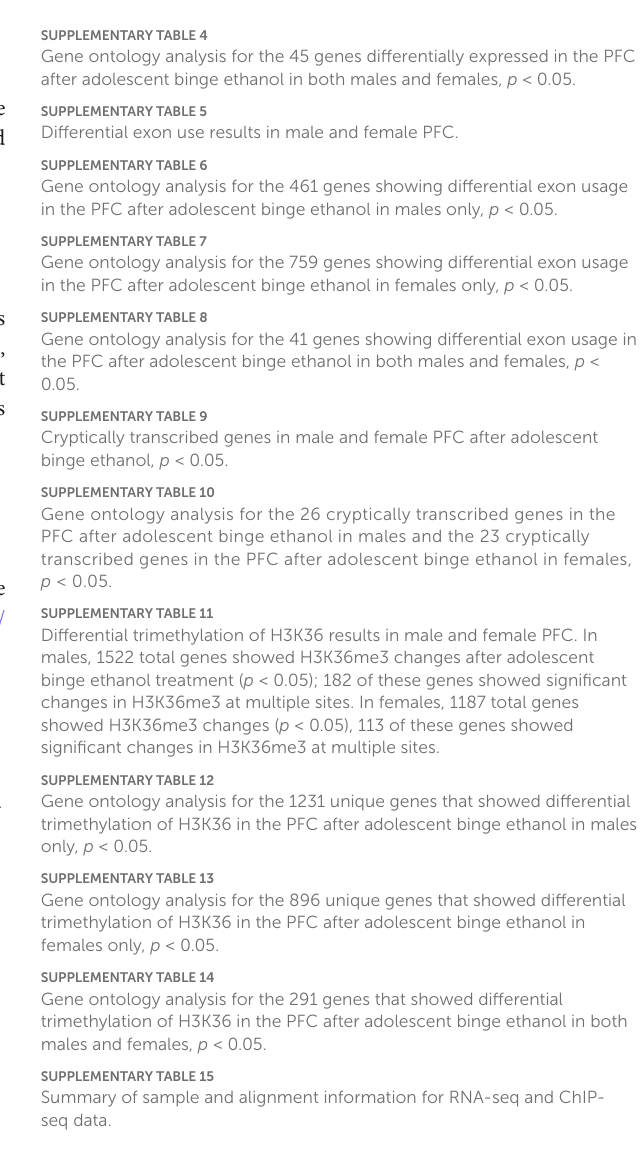
SUPPLEMENTARY TABLE 15 Summary of sample and alignment information for RNA-seq and ChIP- seq